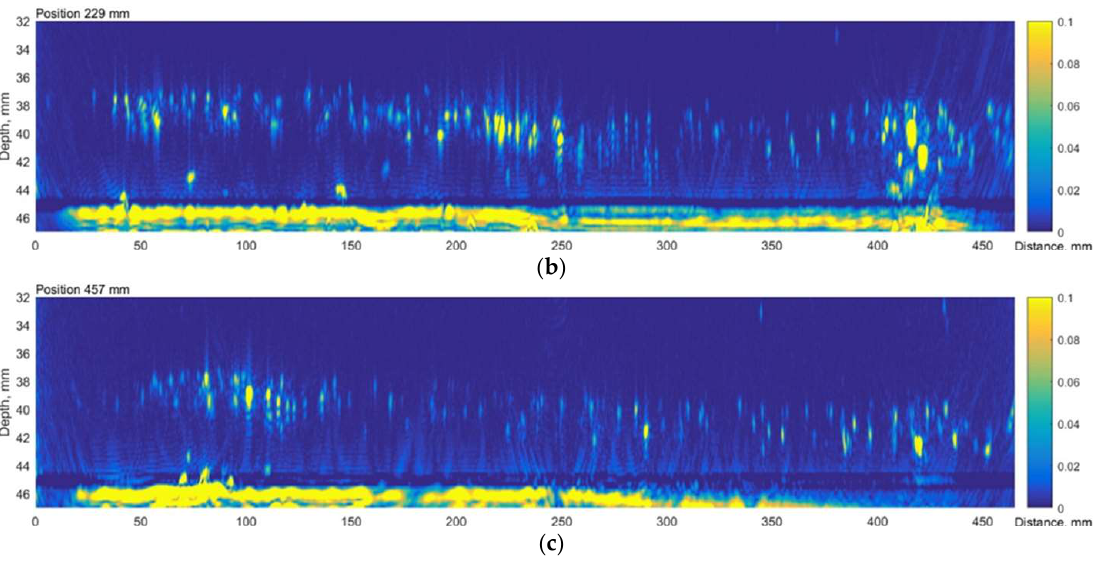
Figure 5. The axial scan B scan images of the TFM reconstruction: ( a ) at 0 mm; ( b ) 229 mm and ( c ) 457 mm circumferential locations. Vertical colour bar represents the peak-to-peak amplitude in arbitrary units.